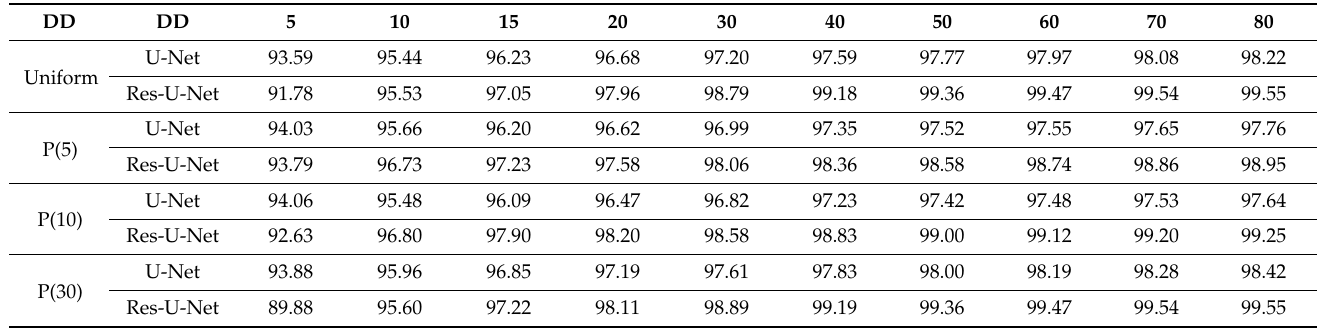
Table 1. Binary accuracy score for the U-net and